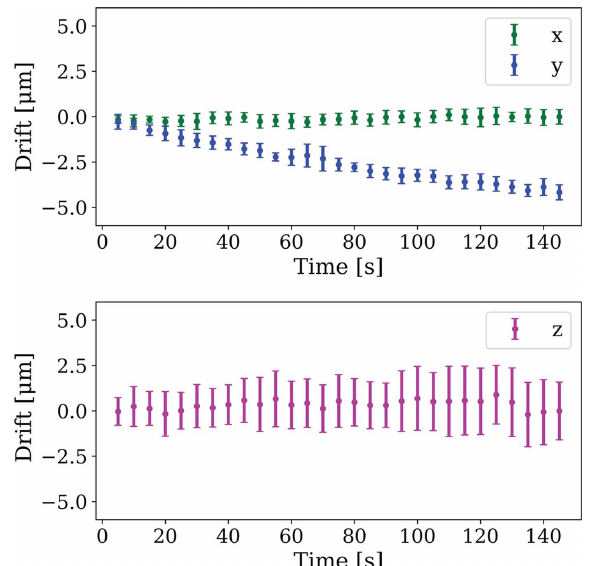
Figure 12 Short-term drifts measured using X-ray diffraction. The time shown is relative to the first frame for each movement cycle, i.e. around 1 min 45 s after the robot has completed the